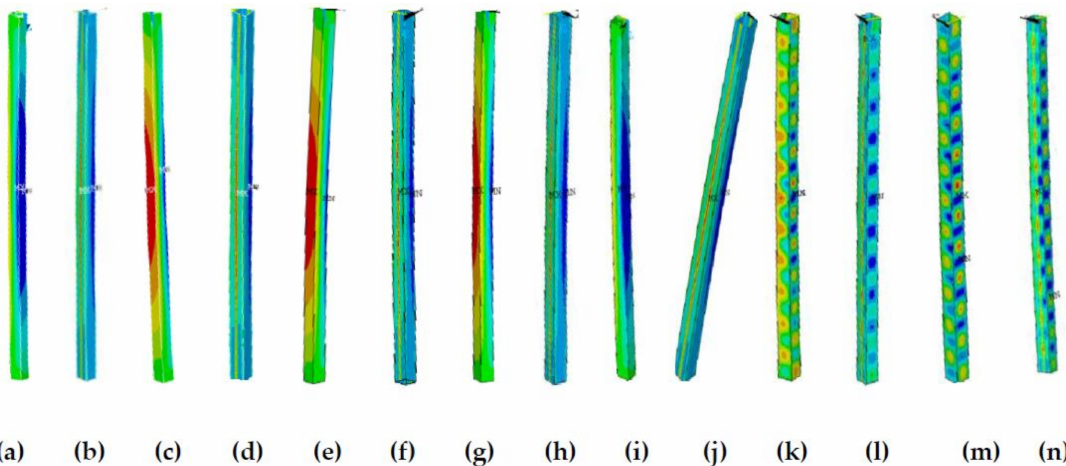
Figure 17. The buckling equivalent stress cloud diagram when λ = 60. ( a ) b / t = 10, ( c ), b / I5, ( e ) b / t = 20, ( g ) b / t = 25, ( i ) b / t = 35, ( k ) b / t = 40, and ( m ) b / t = 50 without residual stress; ( b ) b / t = 10, ( d ) b / t = 15, ( f ) b / t = 20, ( h ) b / t = 25, ( j ) b / t = 35, ( l ) b / t = 40, and ( n ) b / t = 50 with residual stress.